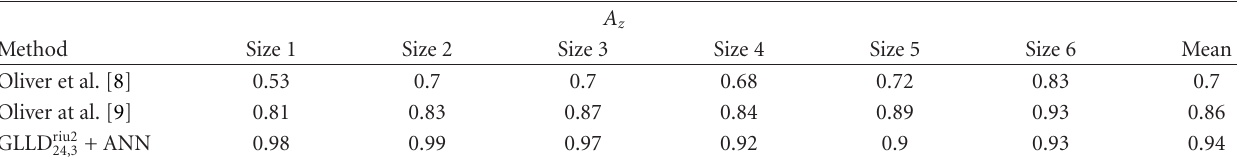
Table 7: Obtained A z values (ratio 1/3) of the classification of masses according to the ROI image sizes. The final column illustrates the mean A z value. Size 1 to size 6 correspond to the di ff erent ROIs image sizes, from smaller to bigger one.